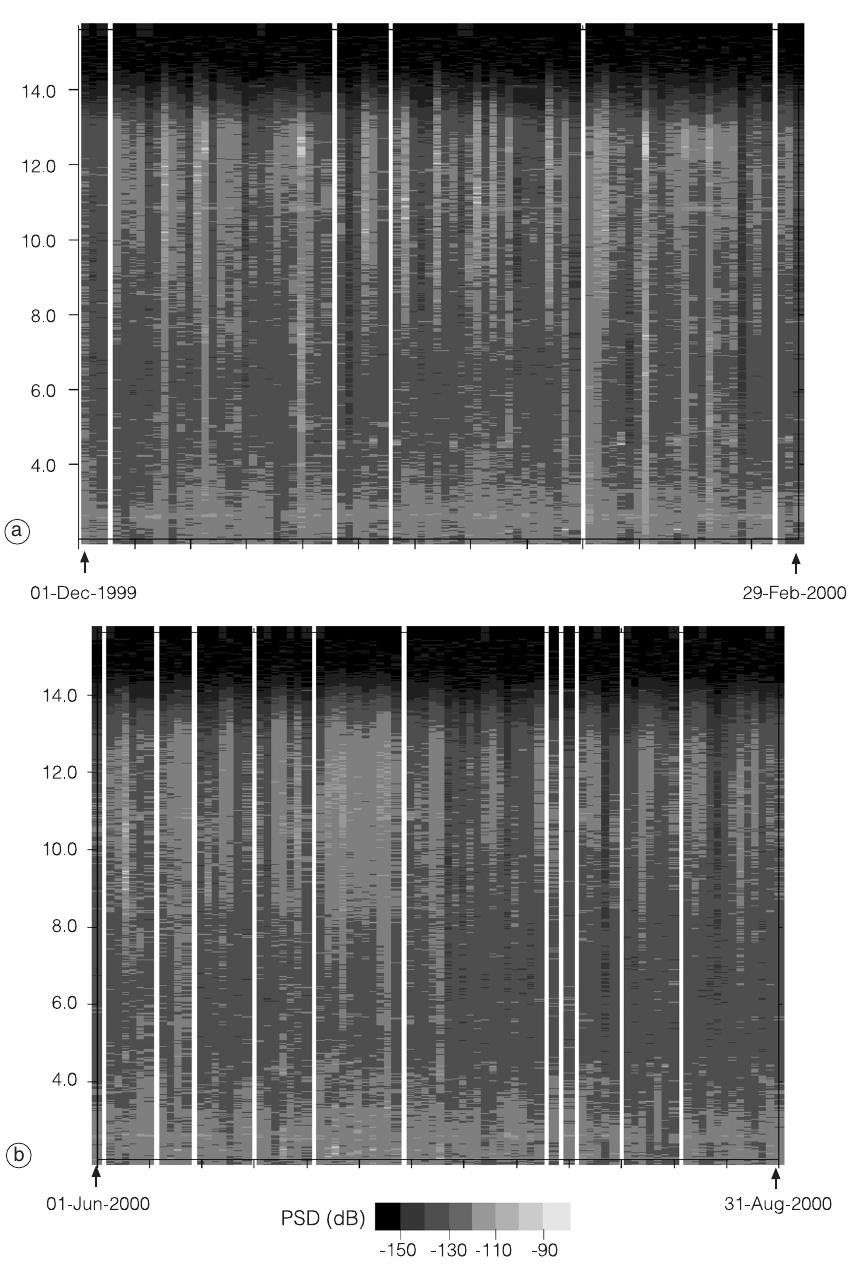
Fig. 12a,b. Spectragrams for: a) 1st December 1999 to 29th February 2000; b) 1st June 2000 to 31st August 2000. The vertical component PSD daily variation from noise samples at 3 AM local time for the frequency band 2 < f < 15.62 Hz is shown. White vertical stripes indicate days for which there are no